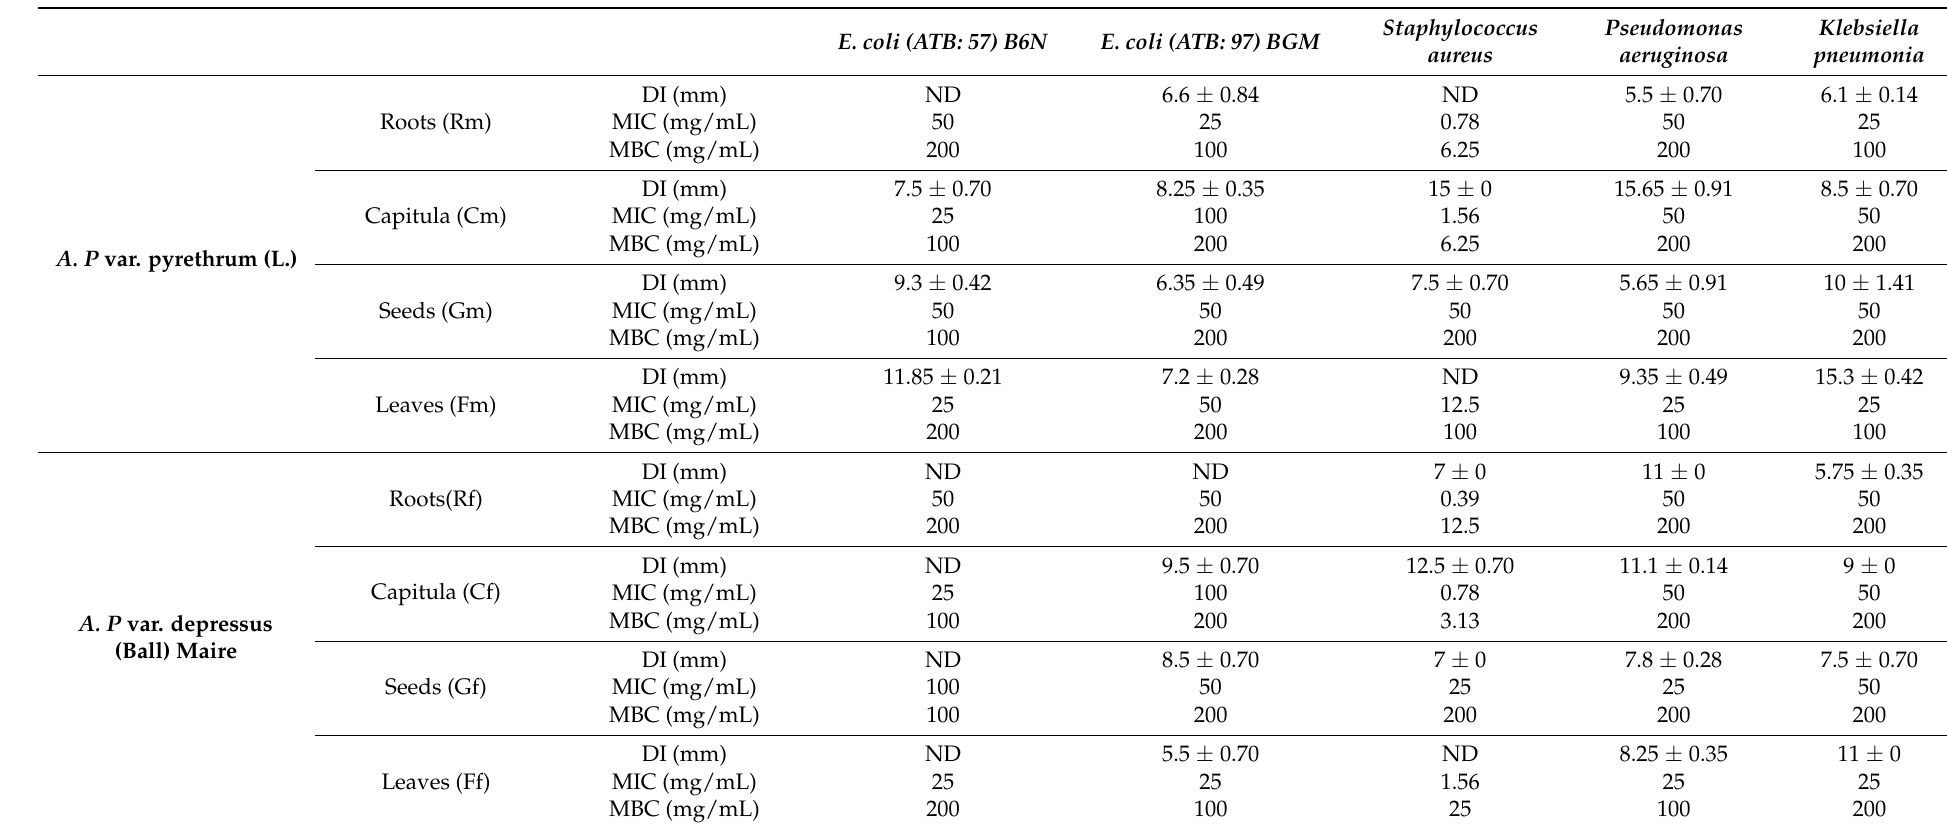
Table 6. The diameter of inhibition zone (DI = mm), the minimum inhibitory concentration (MIC = mg/mL), and minimal bactericidal concentration (MBC = mg/mL) of different extracts from A. P var. pyrethrum (L.) and A. P var. depressus (Ball) Maire.